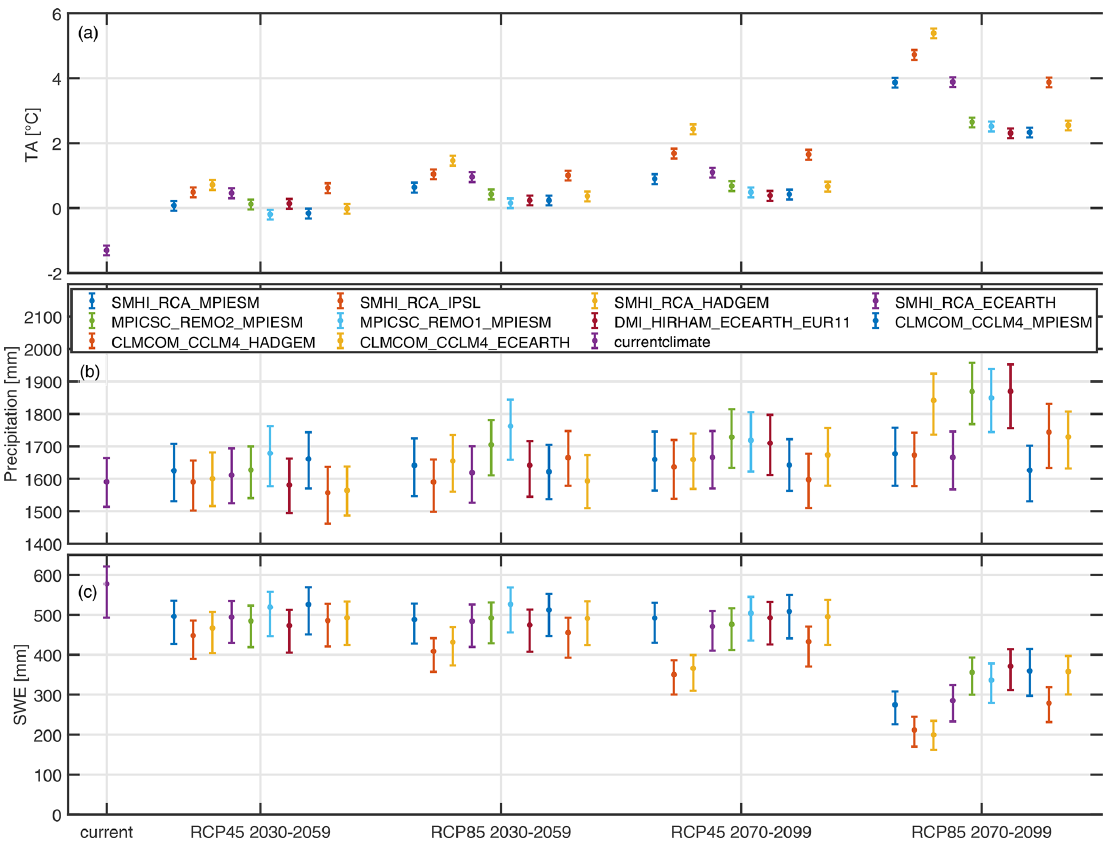
Figure 6. Natural variability and climate model uncertainty in annual and spatial mean (a) precipitation and (b) air temperature ( T A ) and (c) resulting spatial mean SWE on 1 April. Plotted are the 5th, 50th and 95th percentiles from 50 realizations of climate period mean